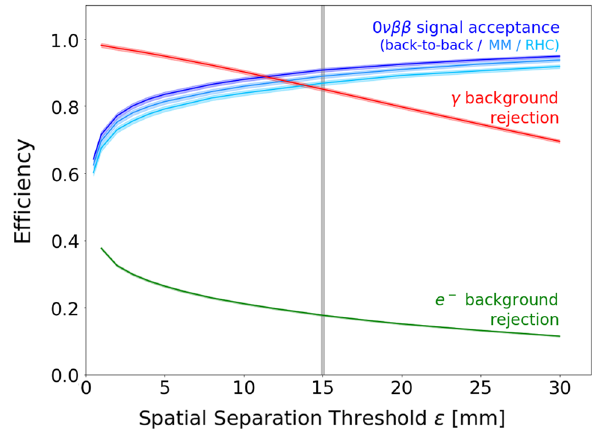
as a function of the spatial separation threshold (cid:7) . The three signal lines (blue) compare different energy and angular distributions based on a back-to-back electron emission, a mass mixing (MM) mechanism and a right-handed current (RHC) model. The background rejection efficiency is shown for γ s (red) and electrons (green) with E = Q ββ . The vertical line (grey) corresponds to the value of (cid:7) assumed in this study. Bands indicate ± 2 σ